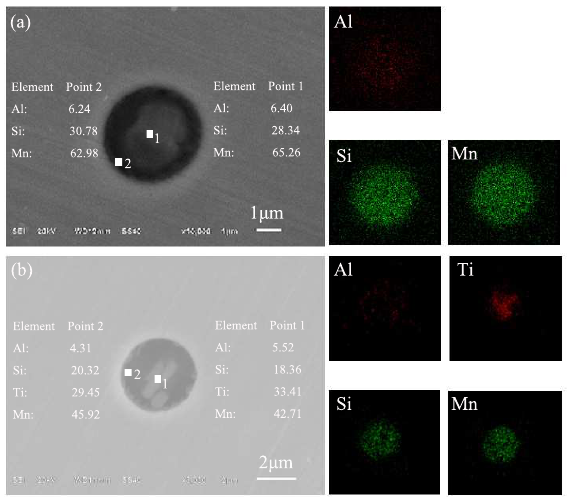
Figure 1: SEM micrographs and EDS mapping images of various elements for typical oxide (a) For Non-treated sample (b) For EAM- treated